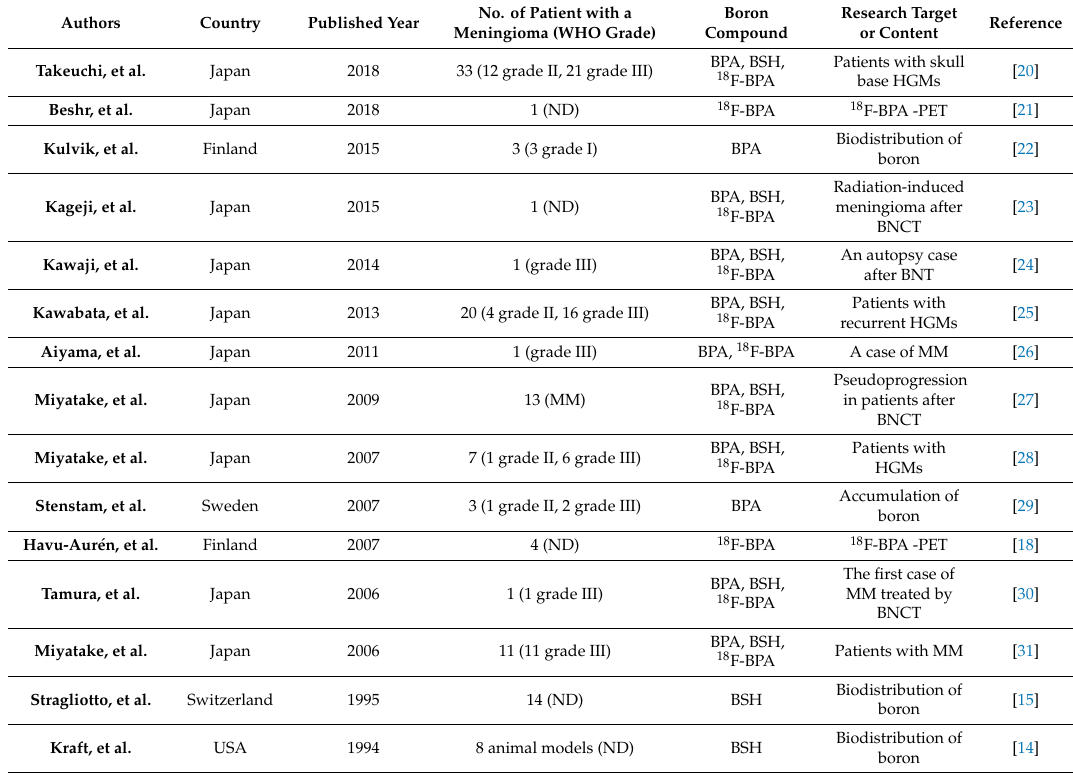
Table 1. Representative clinical reports and studies of BNCT for